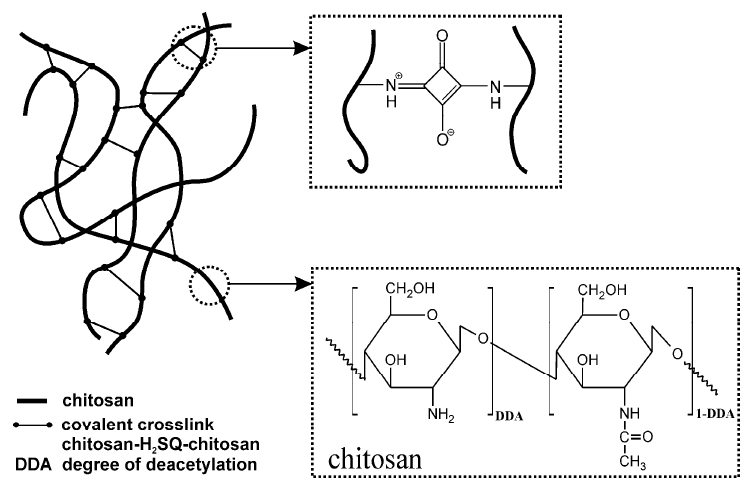
Figure 4. Schematic chemical structure of chitosan crosslinked with squaric acid.